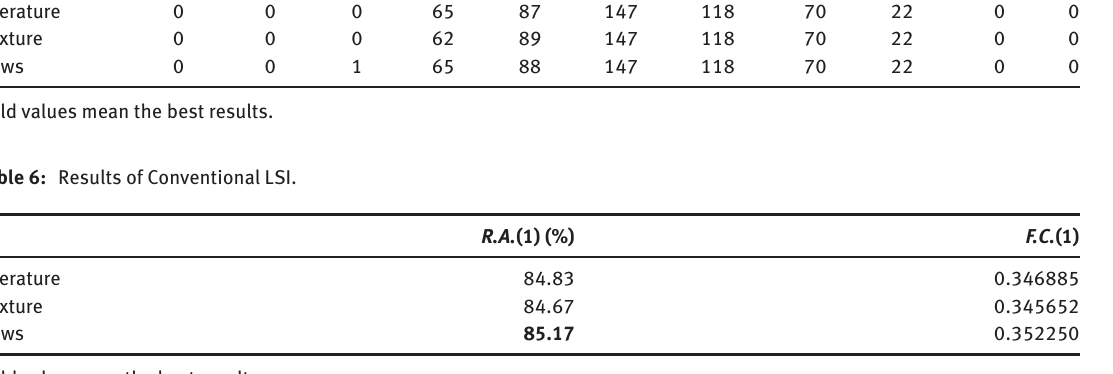
Bold value mean the best